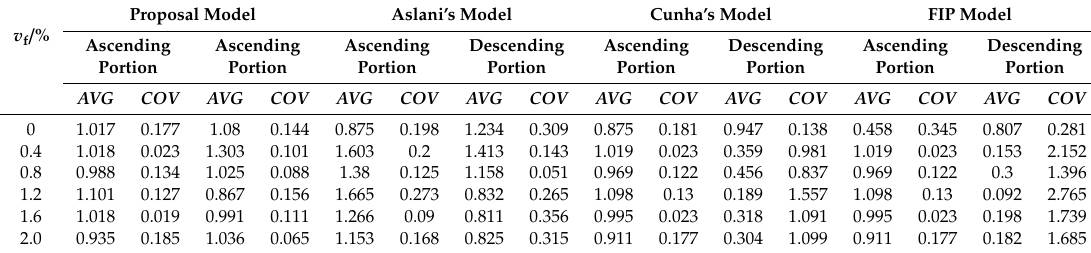
Figure 18. Test and calculated stress-strain curves of self-compacting SFRELC. ( a ) v f = 0 %; ( b ) v f = 0.4 %; ( c ) v f = 0.8 %; ( d ) v f = 1.2 %; ( e ) v f = 1.6 %; ( f ) v f = 2.0 %. Table 5. Calculation results of AVG and COV